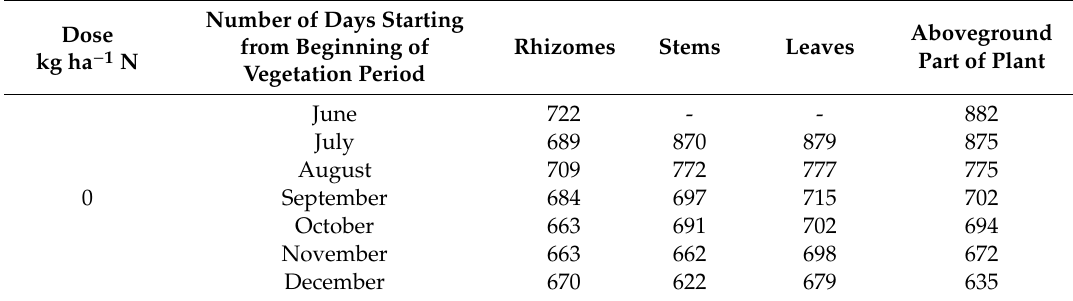
Table 5. Water concentration in the fresh mass of Miscanthus × giganteus (g kg − 1 ) (average for years 2014–2016).